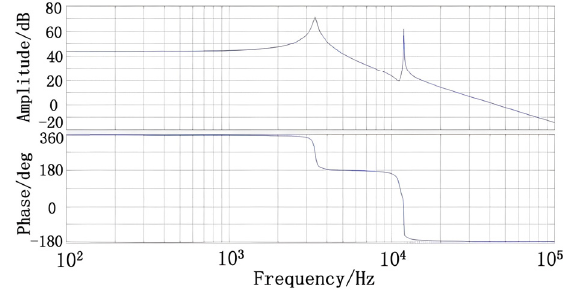
Figure 5. Bode diagram of G vd ( s ).